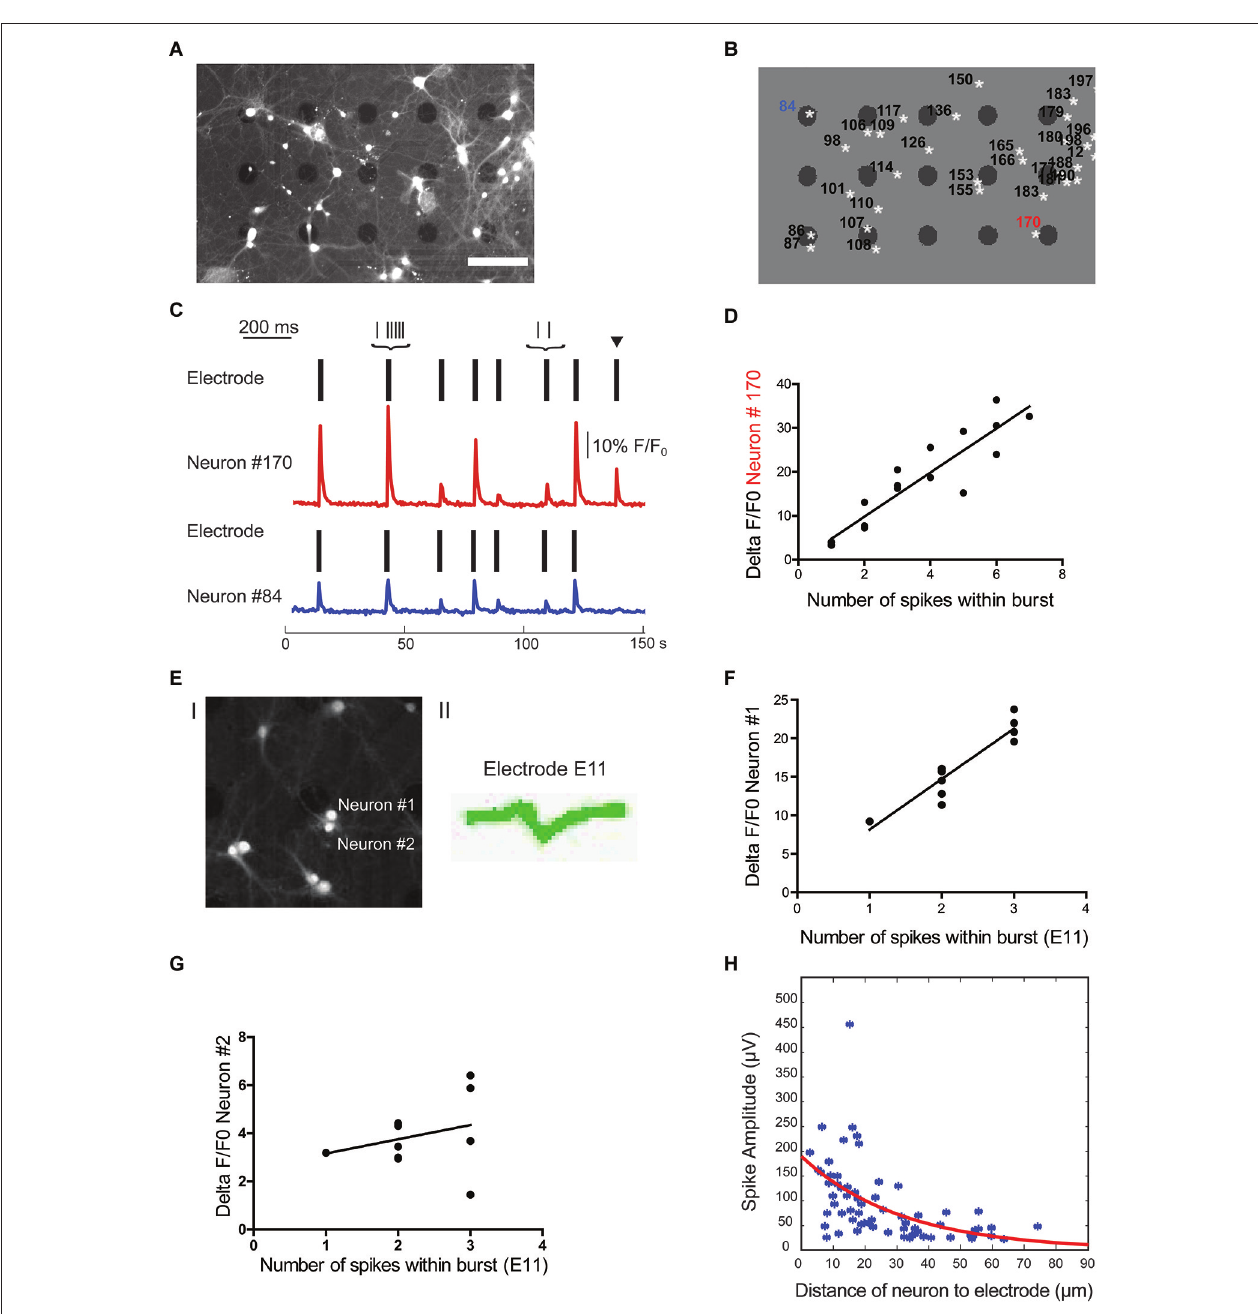
within a burst is linearly correlated with F/F 0 ( R 2 = 0.748 for neuron #170). (E) Fluorescence signal of cells close to one electrode (#E11) after staining with calcium indicator merged with a bright field image to localize electrode E11 (I) as well as the single cluster of spike waveforms detected at electrode E11 (II). (F,G) Correlation of spikes detected at electrode E11 with relative change in calcium signal of nearby neuron #1 (F) and neuron #2 (G) . Only calcium signal from neuron #1 correlates significantly with number of spikes within a burst detected electrically (neuron #1: R 2 = 0.859 and p < 0.0001; neuron #2: R 2 = 0.076 and p = 0.41). (H) Spike amplitude decays exponentially with distance between the cell soma and electrode ( n = 66, R 2 =